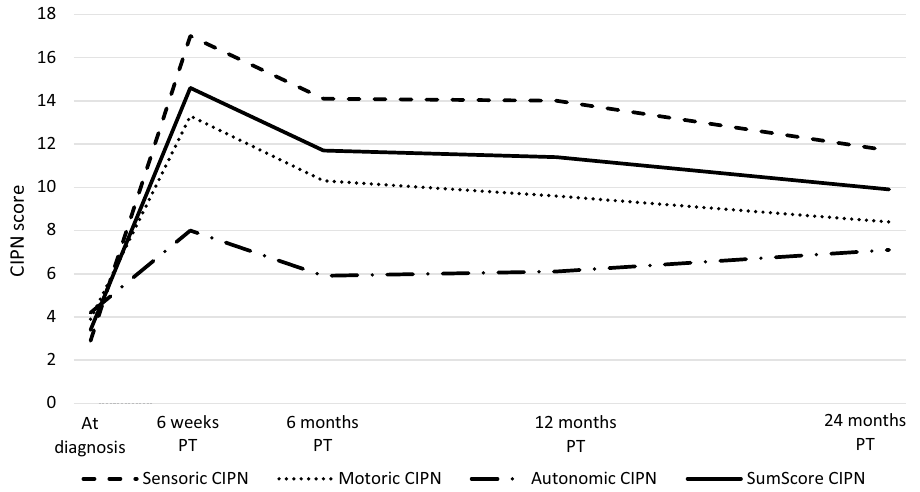
Figure 3. Course of CIPN from diagnosis up to 24 months post-treatment (PT) in colorectal cancer survivors having received chemotherapy in the EnCoRe study. Treatment took place between diagnosis and 6 weeks post-treatment. Course is shown for the different subscales used in the EORTC-CIPN20. CIPN chemotherapy- induced peripheral neuropathy, PT